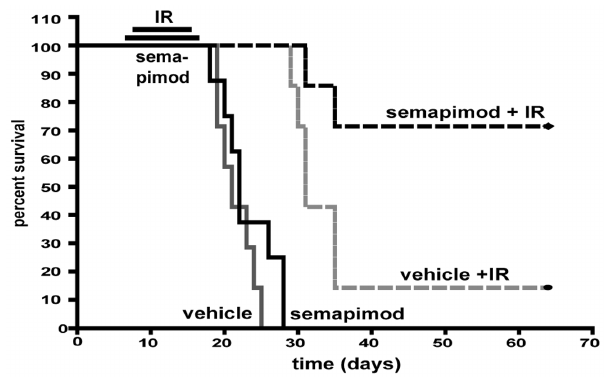
Figure 6. Semapimod increases survival of glioblastoma- bearing mice in conjunction with ionizing radiation. C57Bl/6 mice were injected orthotopically with GL261 cells. Starting 7 days after cell inoculation, the mice were treated intracranially for 2 weeks with semapimod, delivered via an osmotic pump. Starting on day 8, animals were given 2 Gy whole brain irradiation every other day over a period of 10 days (10 Gy total). *: p , 0.05. Chi square test, with 3 degrees of freedom.